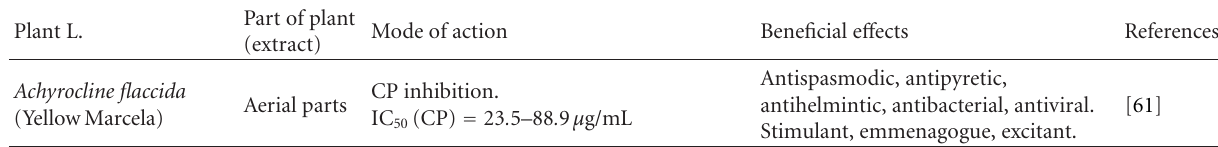
Table 2: An overview of complement inhibitors in extracts from plant